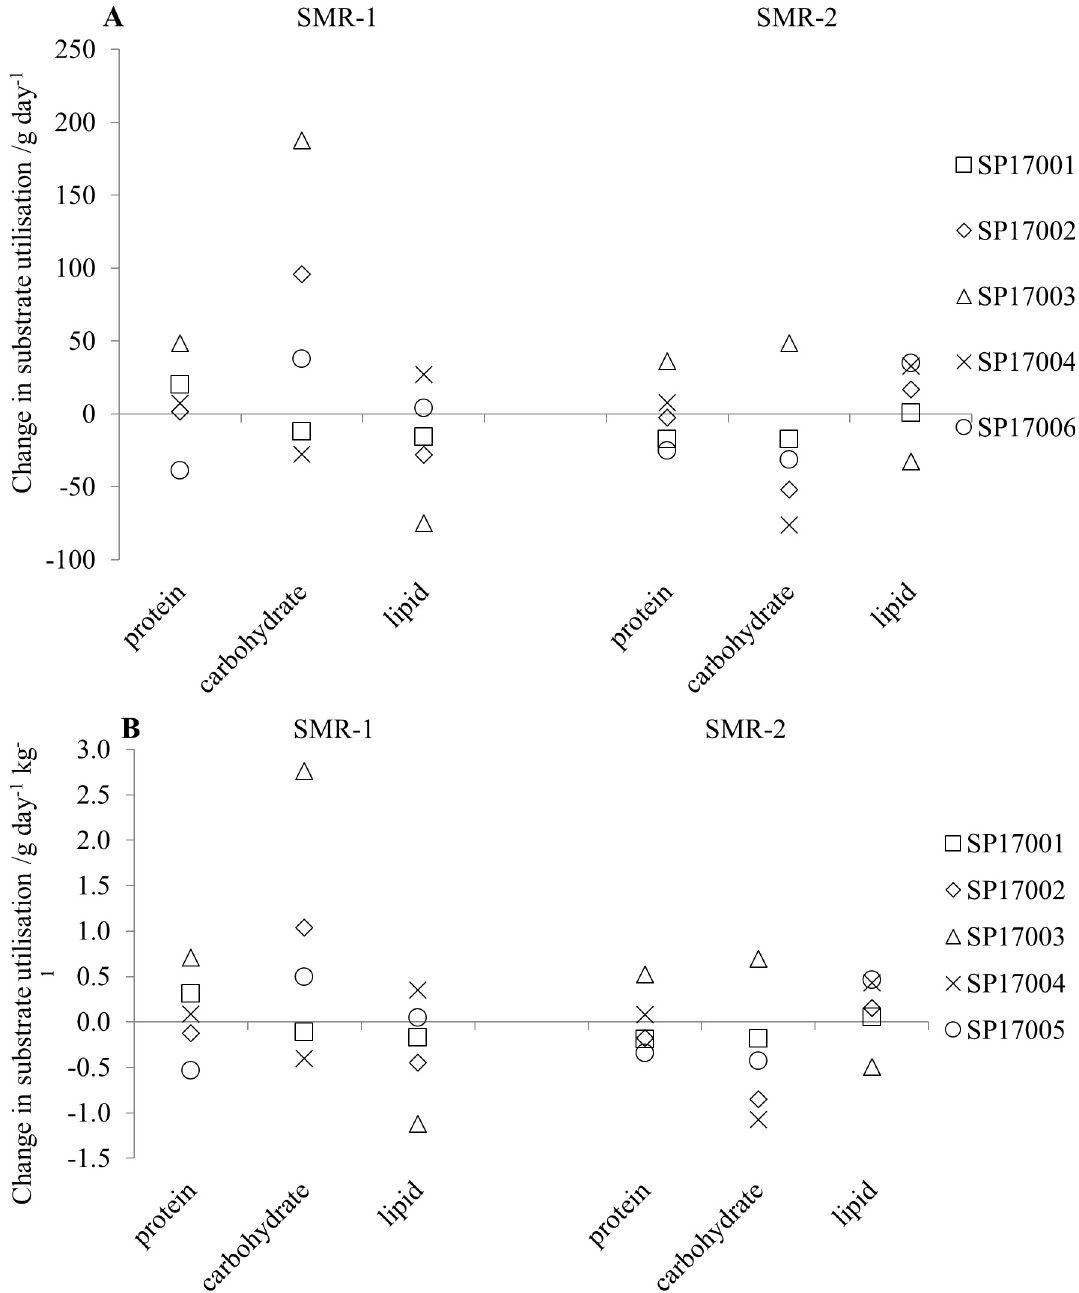
Fig 5. The change in substrate utilisation (post-expedition–pre-expedition) during the two sleep periods (SMR-1 and SMR-2). (A) raw values; (B) the values normalised to lean tissue weight. sample period covered all three exercise sessions. The average change in carbohydrate utilisa- tion values for the three exercise intensities were: 28 (31) g day -1 , -17 (302) g day -1 and 83 (241) g day -1 for EMR-80, EMR-100 and EMR-120, respectively. Whilst there was an average increase in the carbohydrate utilisation and reduction in the protein utilisation for the other exercise intensities, the direction of the change was not consistent across the different